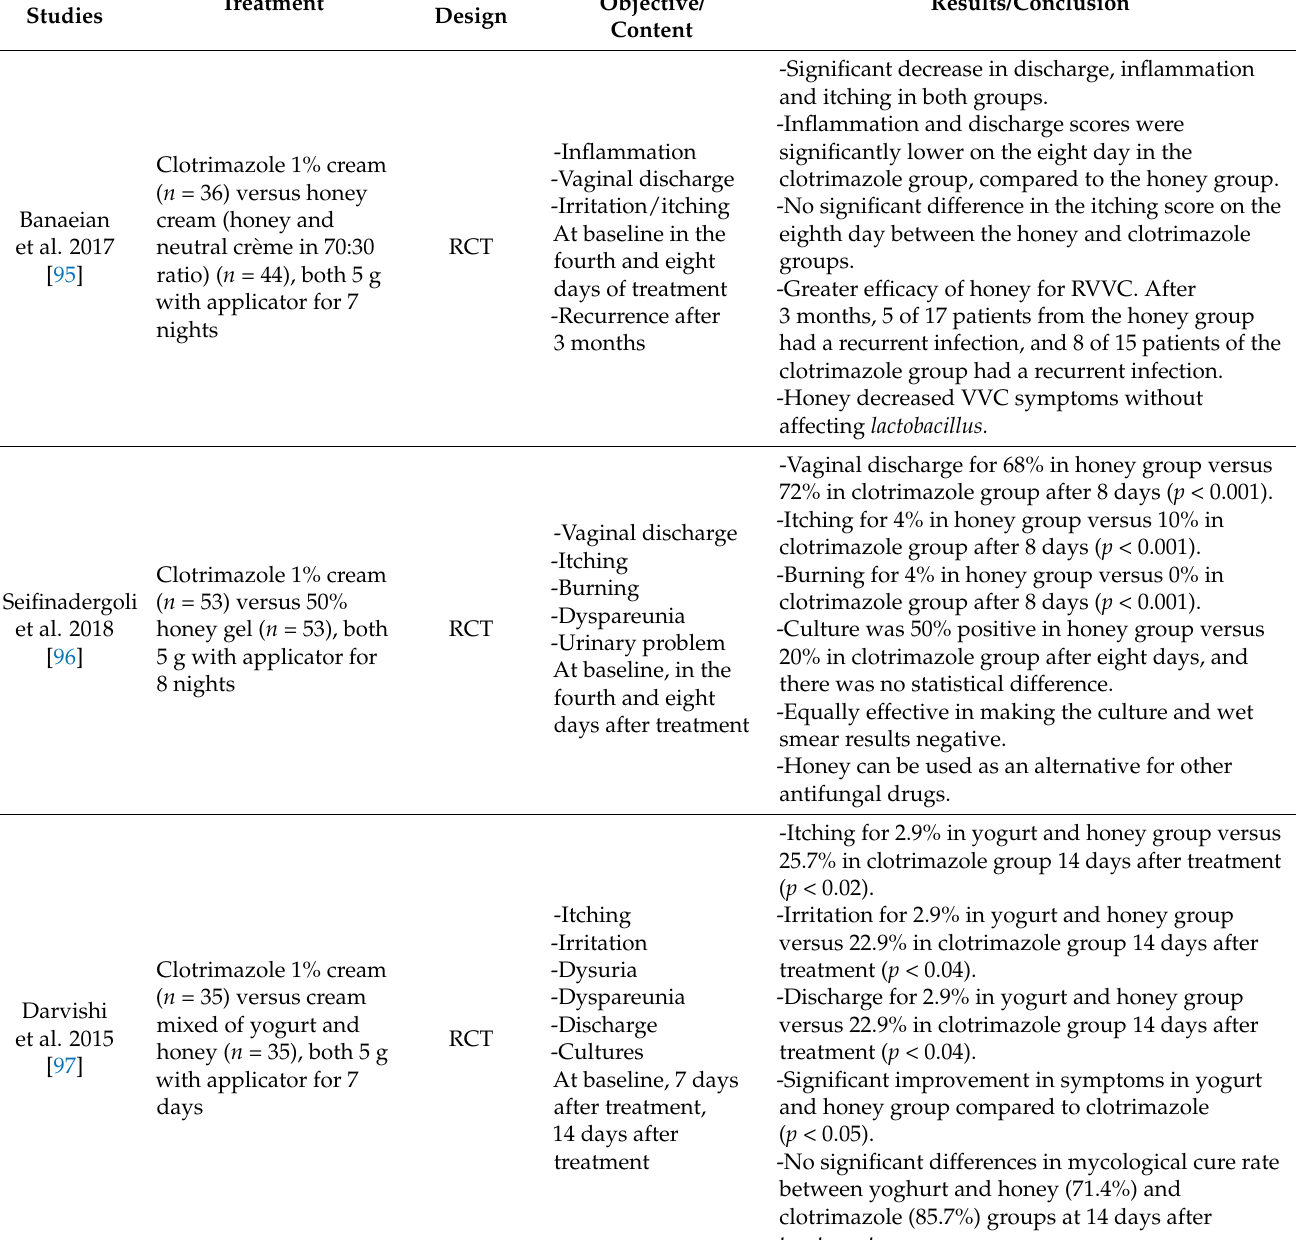
Table 3. Overview clinical studies investigating the effect of honey on VVC. RCT: randomized controlled trial.